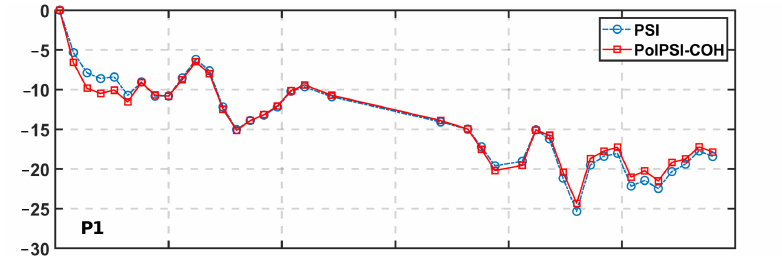
Figure 12. The deformation time-series of a selected pixel P1 within the Laobata coal fire area. The location of P1 is highlighted by the white circle in Figure